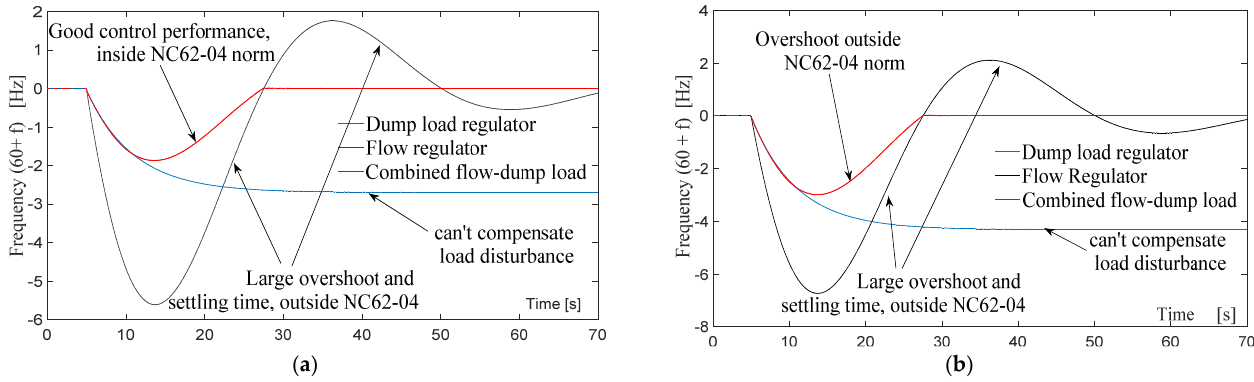
Figure 6. ( a ). Frequency behavior of all regulator with sustained load disturbances of 10%. ( b ). Frequency behavior of all regulators with sustained load disturbances of 12%.